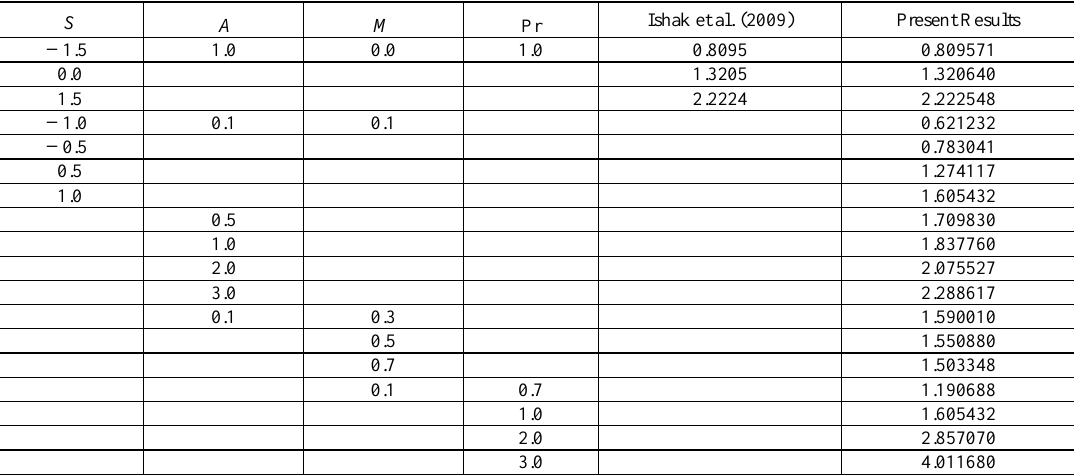
Table 2. Comparison of ) 0 (    for various values